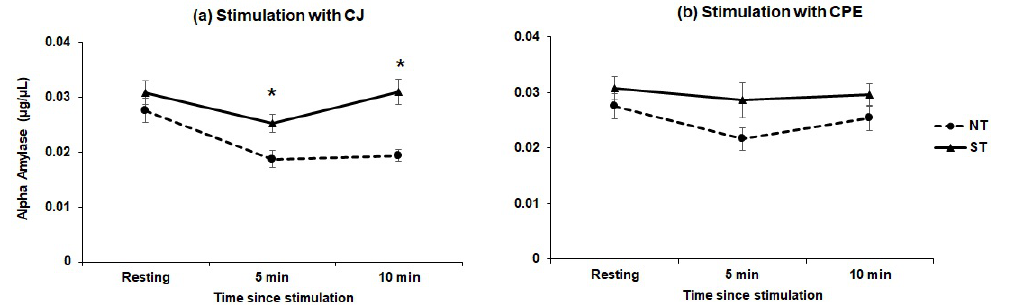
Figure 6. E ff ect of stimulation on alpha-amylase levels ( µ g / µ L) after stimulation with CJ ( a ) and CPE ( b ). * indicates a di ff erence between non-tasters and super-tasters ( p < 0.014–0.000) at a given time point. Non-tasters ( n = 29) and super-tasters ( n =